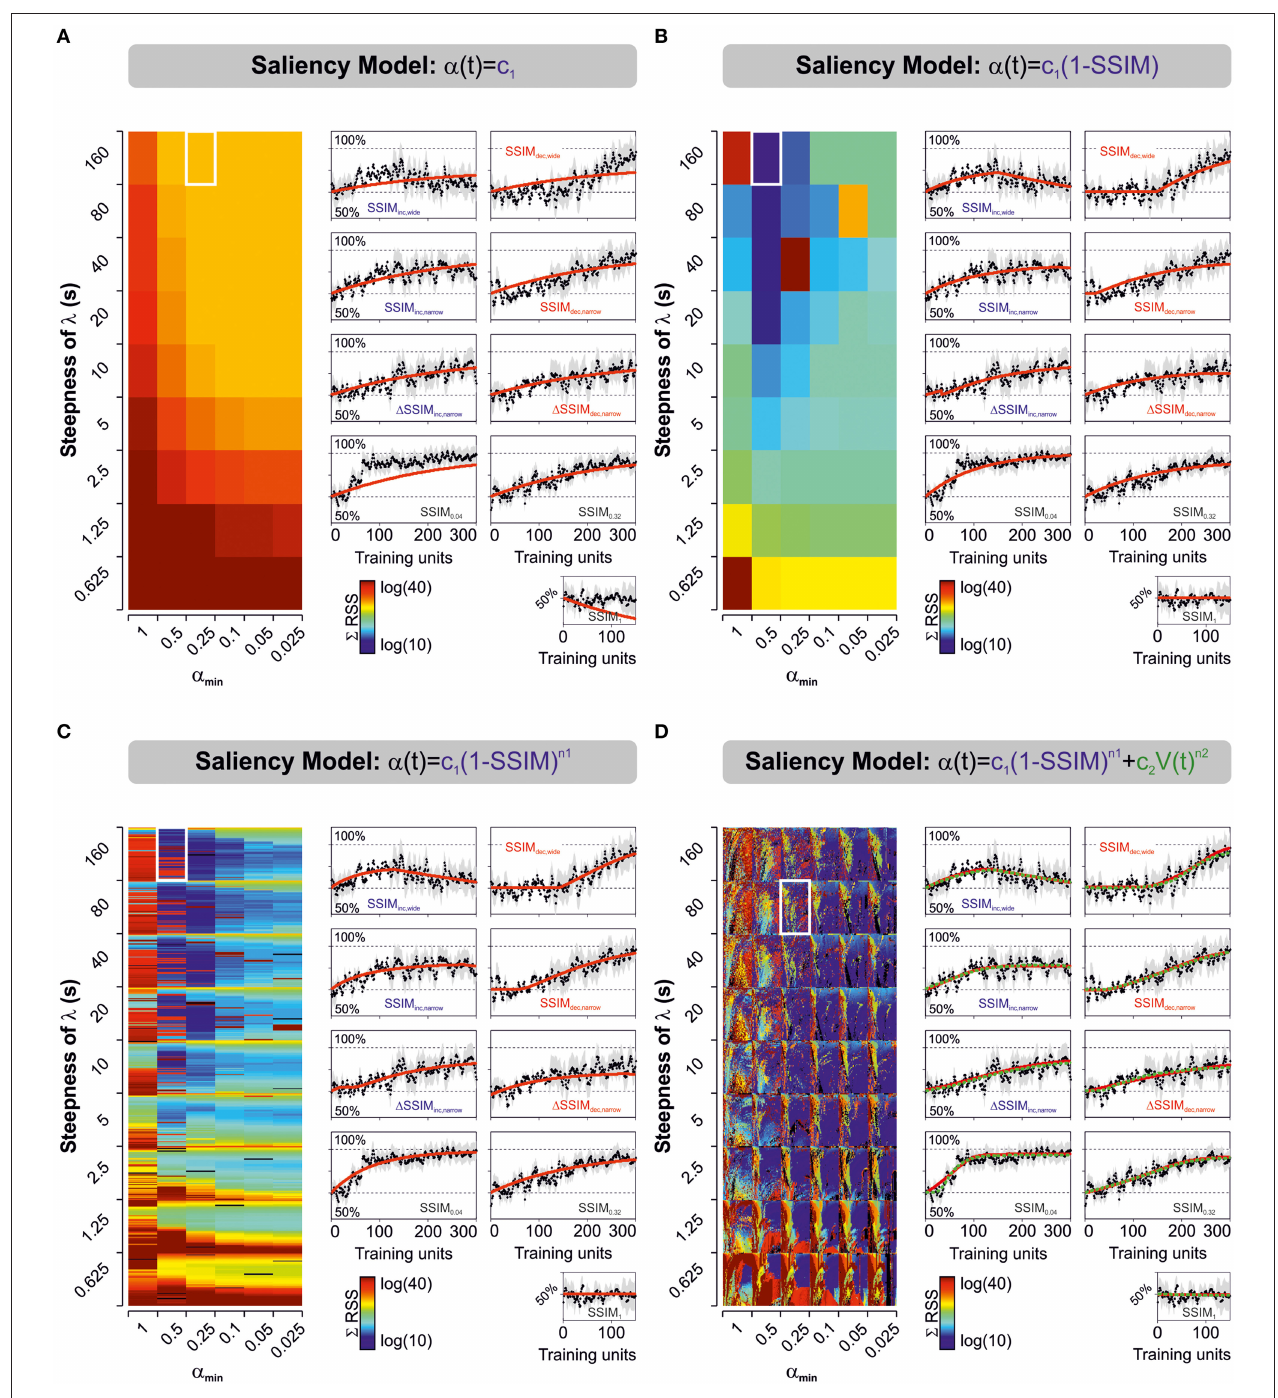
FIGURE 2 | Predicted learning curves using different parameterizations for stimulus salience. Predicted learning curves (red lines) fitted to the empirical average choice records from mice trained with varying and constant stimulus similarity. Salience was represented as either a simple constant (A) , as a linear (B) , or non-linear (C) function of stimulus similarity (SSIM), or as the sum of two non-linear functions, one dependent on stimulus similarity, and the other on V (t) (D) . Color-maps display the sum of squares ( 6 RSS) for all nine experimental groups (same color scale for all cases). In (C) we mapped for different values of n 1 ( n 1 ≥ 0:0.1:6, y-axis), whereas in (D) we mapped for n 1 (y-axis) and n 2 ( n 2 = 0:0.1:6; x-axis). Common to all groups: β , c 1 , k 2 , and α min . In (D) , the red and green lines correspond to the best “unbound” (0 > φ ≥ ∞; 0 > ε ≥ ∞ ) and “bound” (0 > φ ≥ 1 ; 0 > ε ≥ 1) solutions, respectively. The best parameter fits for the unbound solution were β = 0.0154; k 1 = 0.0014 ; V min = 0.55 ; λ max = [1, 0.97, 0.77, 0.95, 0.84, 0.85, 0.70, 0.90, 0.93]; s = 80 ; α min = 0.25 ; c 1 = 0.3827 ; n 1 = 1.5 ; c 2 = [0.31, 4.01, 12.91, 2.15, 2.92, 1.41, 0.00, 3.36, 9.56]; n 2 = 6, whereas those for the bound solution were β = 0.0140; k 1 = 0.0014 ; V min = 0.55; λ max = [1, 0.95, 0.77, 0.95, 0.85, 0.86, 0.70, 0.90, 0.93]; s = 80 ; α min = 0.25 ; c 1 = 0.6762 ; n 1 = 2.7 ; c 2 = [0.27, 4.57, 10.88, 2.30, 2.64, 1.08, 0.00, 3.63, 7.11]; n 2 = 5.6 . The arrangement of the panels with the learning curves is identical to the one described for Figures 1C,D .